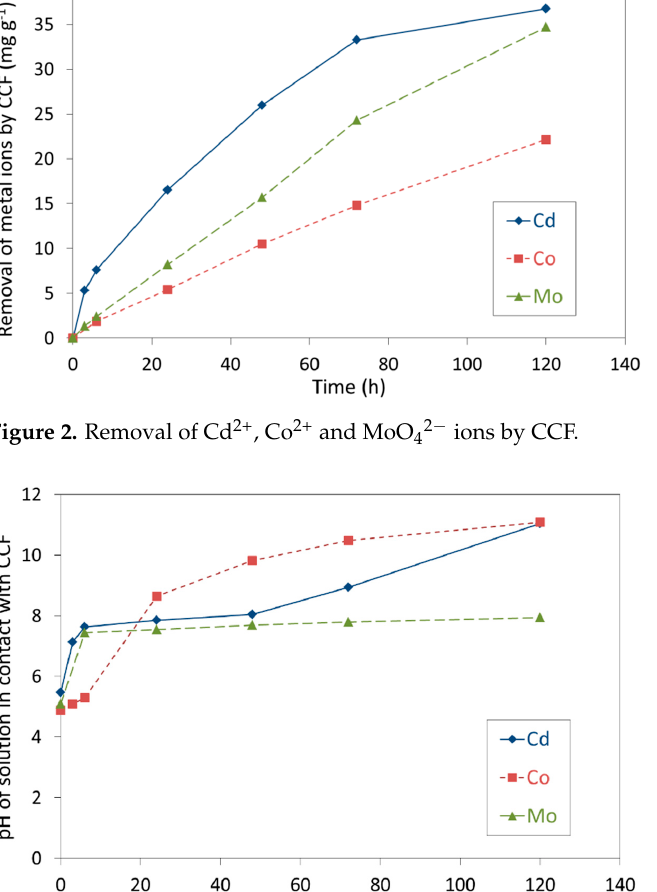
Figure 2. Removal of Cd 2+ , Co 2+ and MoO 42 − ions by CCF.